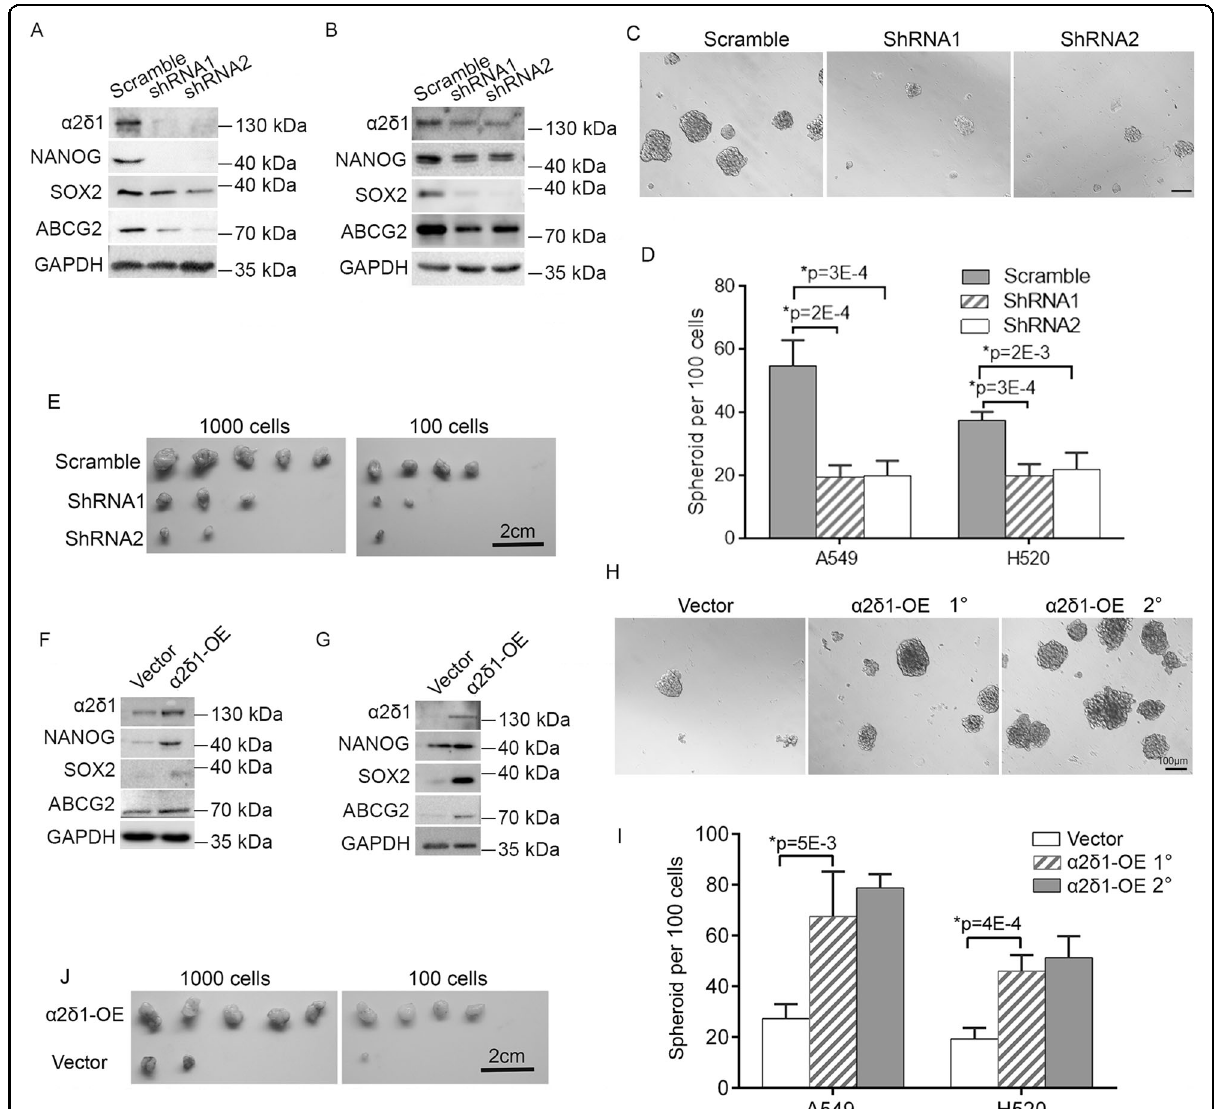
Fig. 4 The roles of α 2 δ 1 in the determination of NSCLC TIC ’ s properties. A , B Western blot results showing the effects of α 2 δ 1 knockdown on the expression of indicated molecules in the sorted α 2 δ 1 + subsets from the NSCLC cell lines A549 ( A ) and H520 ( B ). C Representative phase-contrast micrographs demonstrating the effect of α 2 δ 1 knockdown on the spheroid formation of α 2 δ 1 + A549 cells. Scale bar, 100 μ m. D Histograms showing the spheroid forming ef fi ciencies of the α 2 δ 1 + subsets from indicated sources after α 2 δ 1 knockdown with shRNAs ( n = 4). E The effect of α 2 δ 1 knockdown on the tumor-initiation ability of α 2 δ 1 + A549 cells ( n = 5). F , G Western blot analyses of the expression of indicated molecules in A549 ( F ) and H520 ( G ) cells overexpressing α 2 δ 1. ( H ) Representative phase-contrast micrographs showing the spheroids formed by A549 cells overexpressing α 2 δ 1. I Histograms showing the primary (1°) and subsequently passaged (2°) spheroid forming ef fi ciencies of indicated cells overexpressing α 2 δ 1 ( n = 4). J Photograph of dissected tumors showing the tumor-initiating ability of α 2 δ 1 − A549 cells overexpressing α 2 δ 1 by limiting dilution transplantation in NOD-SCID mice ( n = 5). The error bars in ( D ) and ( I ) represent SD of three independent experiments. *Student ’ s t -test. OE